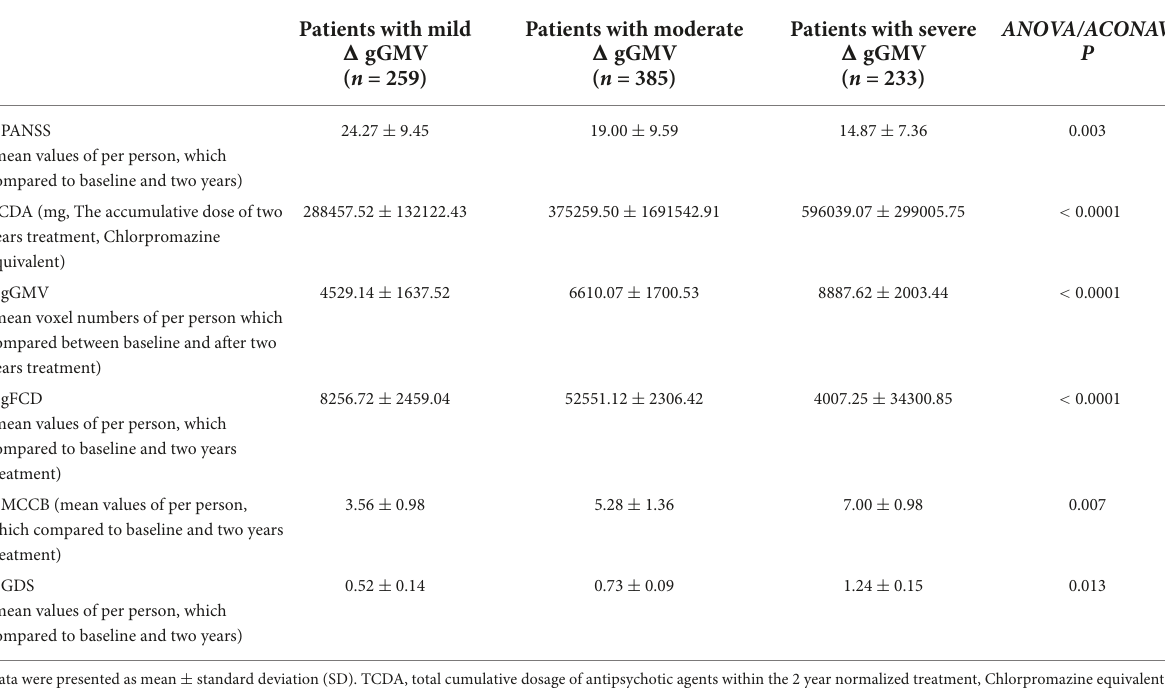
TABLE 2 Clinical characteristics of patients in different groups and healthy controls.